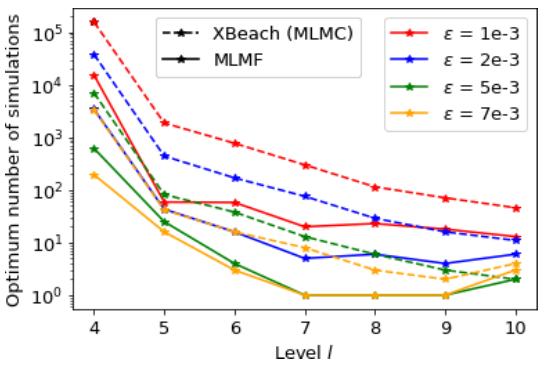
Figure 9. Optimum number of XBeach (HF) simulations required by MLMF (Eq. 14) and MLMC (Eq. B7) for the non-breaking wave test case. The number required by MLMF is always substantially fewer than that required by MLMC.